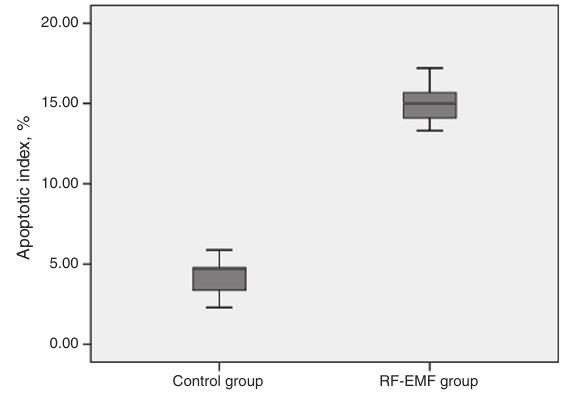
Figure 3 Graph of apoptotic index for